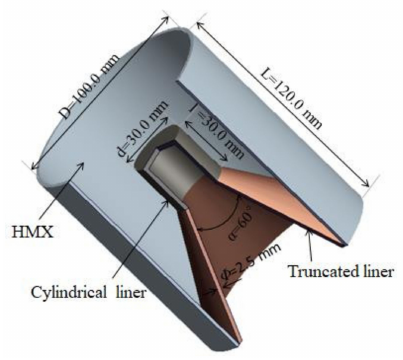
Figure 1. The structure parameters of the cylinder-cone-shaped